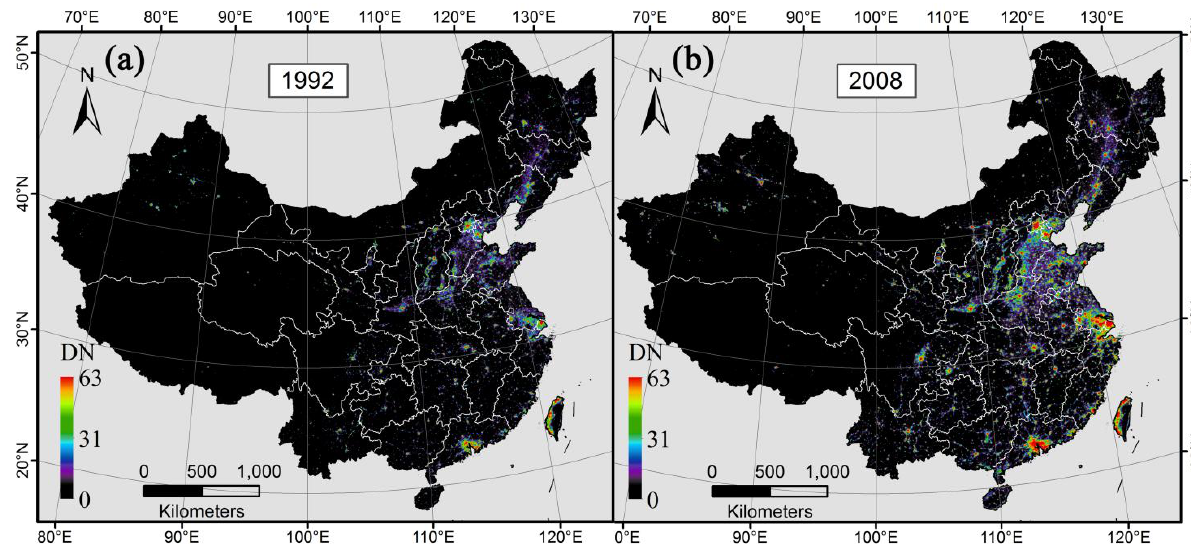
Figure 3. Spatial distribution of DMSP/OLS nighttime lights in China in ( a ) 1992 and ( b )